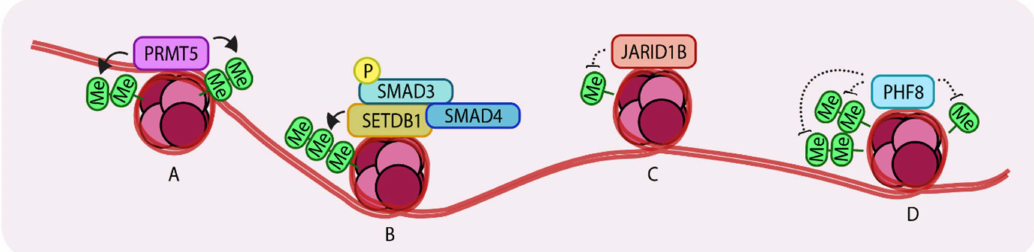
Figure 3. Representation of Histone methyltransferases and demethylases acting on histones. ( A ) PRMT5 (Protein arginine methyltransferase) (di-) methylates H3R2 (histone 3, arginine 2) and H4R3 which leads to enhanced transcription. ( B ) SETDB1 (Set domain bifurcated 1) tri-methylates H3K9 to repress SNAI1 transcription. ( C ) JARID1B (Jumonji / ARID domain-containing protein 1B) de-methylates H3K4 to promote growth in breast cancer cells. ( D ) PHF8 (PHD finger protein 8) recognizes and demethylates H3K9me2, H3K29me2 and H4K20me leading to enhanced gene expression. Arrows indicate addition and dotted lines indicate removal of methyl groups. ‘Me’ in green circles indicates